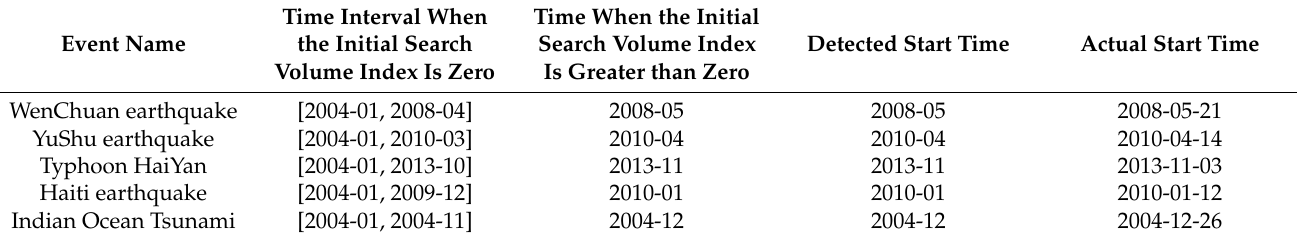
Table 1. Comparisons between the detected and actual start time.